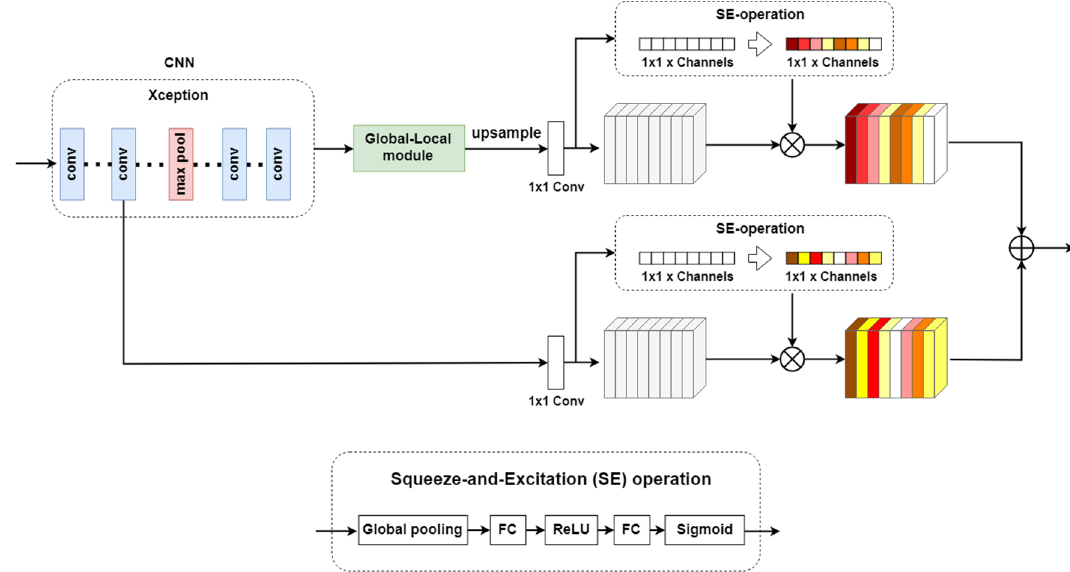
Figure 5. The Channel attention module. The output of the Global-Local module is up-sampled to match the size of the CNN feature map before the fusion process, and the SE operation explores channel dependency in the feature map.